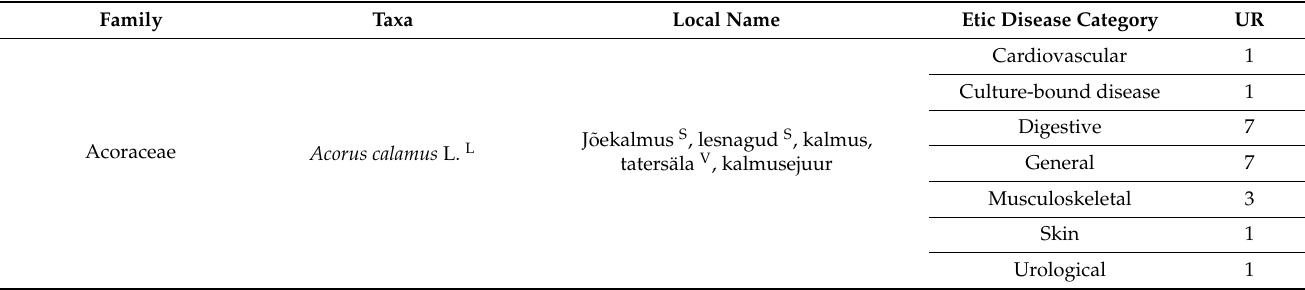
Table 3. Plants and their uses from folklore